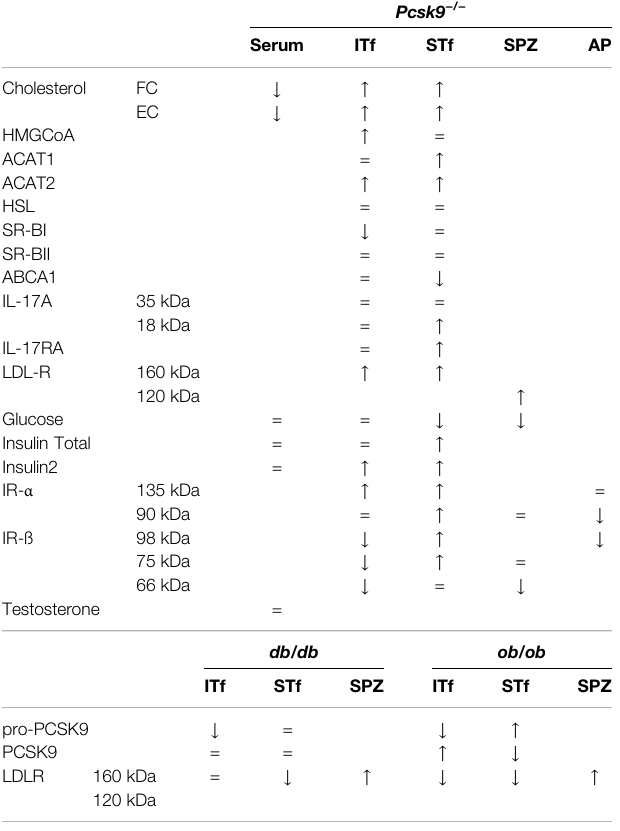
TABLE 1 | An overview of the changes in cholesterol, enzymes, transporters, IL- 17A,IL-17RA,LDL-R,glucose, Insulin Total, Insulin2,IR- α ,IR- β ,testosterone in serum, interstitial tissue (ITf), seminiferous tubule-fractions (STf), epididymal spermatozoa (SPZ) and anterior pituitary (AP) in Pcsk9 − / − mice and in db/db and ob/ob mice compared to the WT